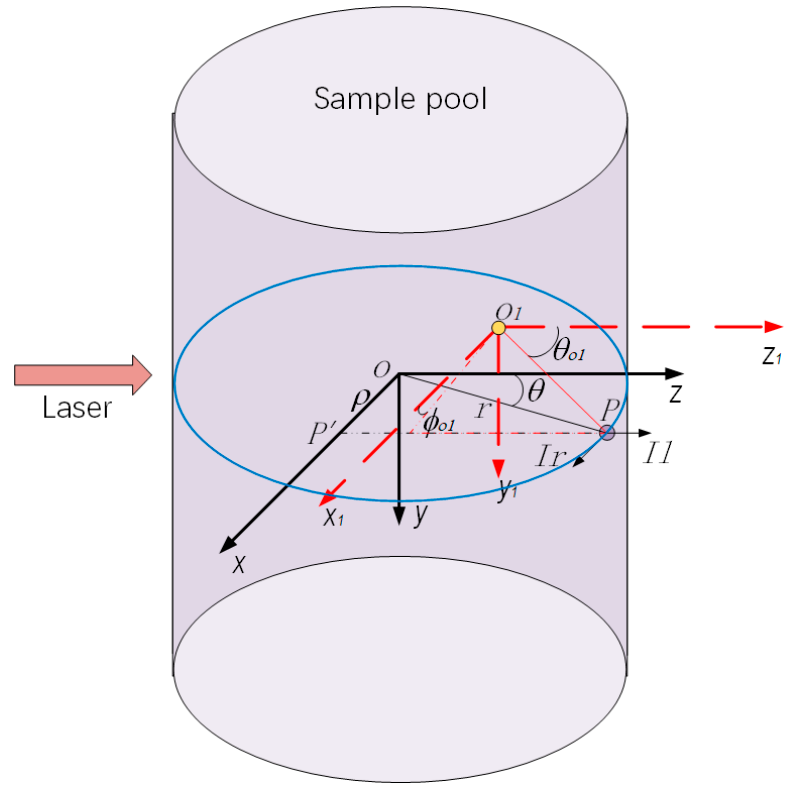
Figure 4. Diagram of the coordinate system.